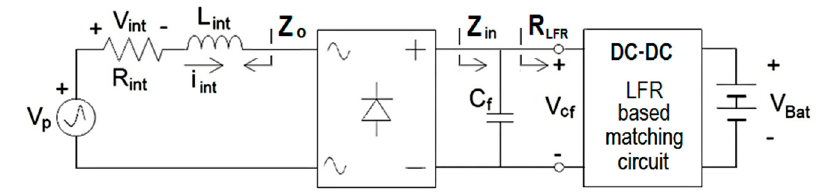
Figure 9. Proposed matching idea using the generator equivalent circuit.